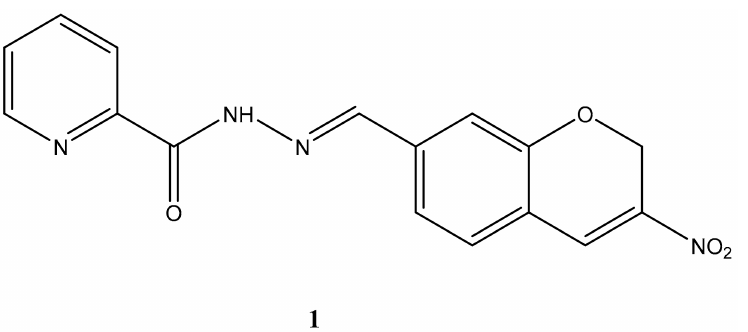
Figure 2. The structure of PAC.